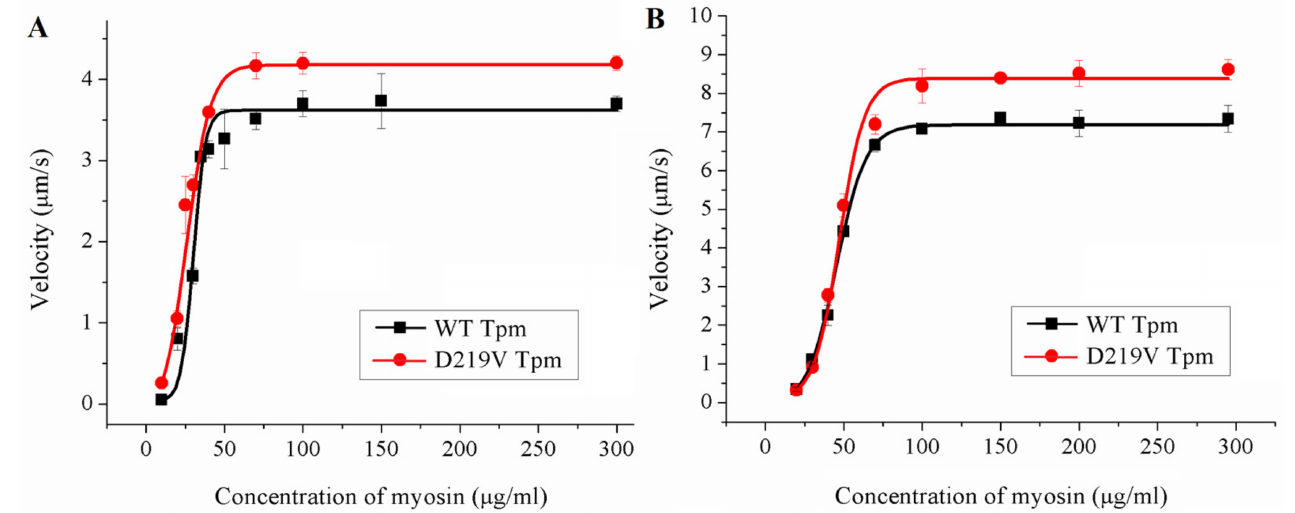
Figure 6. The dependence of the maximal sliding velocity of thin filaments with WT and D219V Tpm at saturated Ca 2+ concentration on LV ( A ) and LA ( B ) myosin concentrations added to the flow cell. C 50 for LV myosin with WT Tpm was 30.1 ± 0.9 µ g/mL and 25.9 ± 3.1 µ g/mL with D219V Tpm. The C 50 for LA myosin with WT Tpm was 45.3 ± 1.5 µ g/mL and 47.2 ± 1.1 µ g/mL with D219V